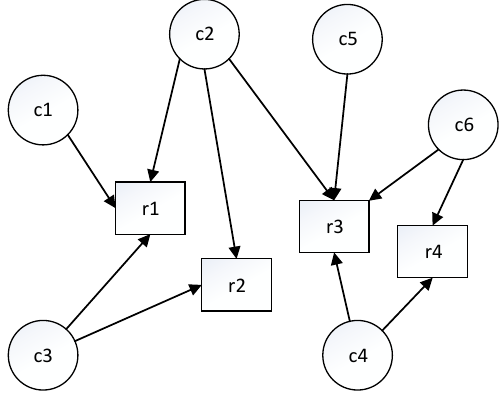
Figure 4. The semantic match is used to construct a directed